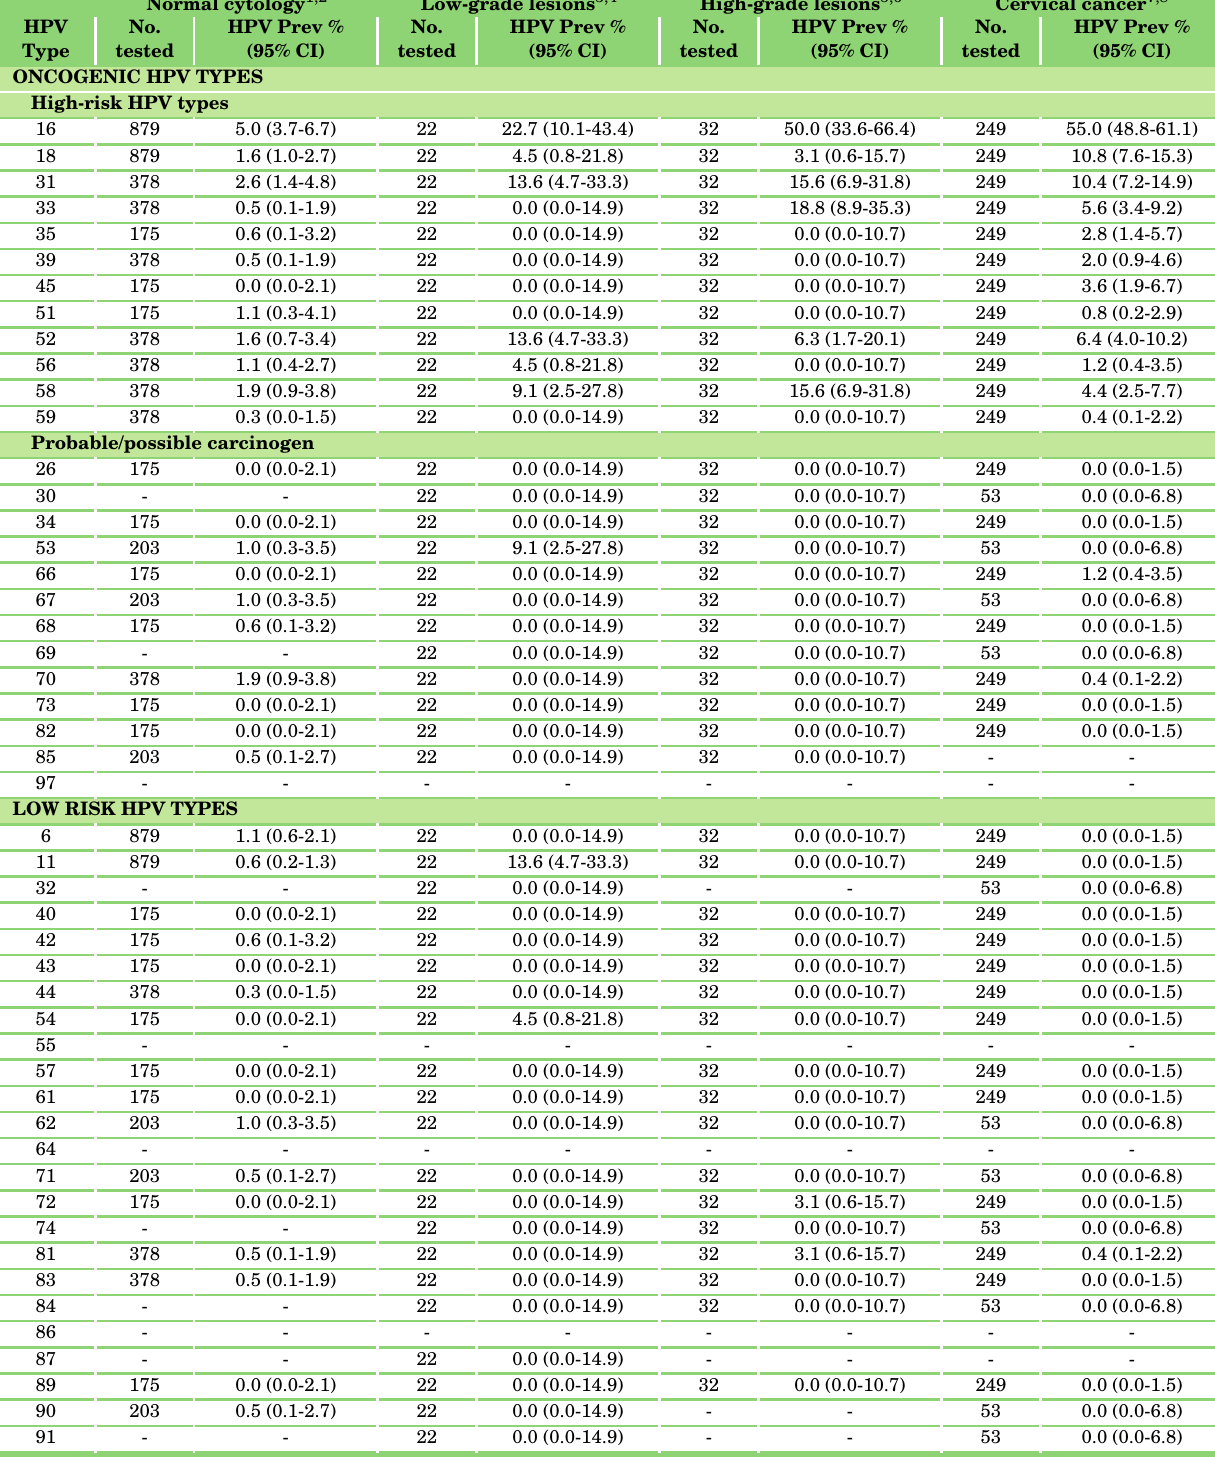
Table 22: Type-specific HPV prevalence in women with normal cervical cytology, precancerous cervical lesions and invasive cervical cancer in